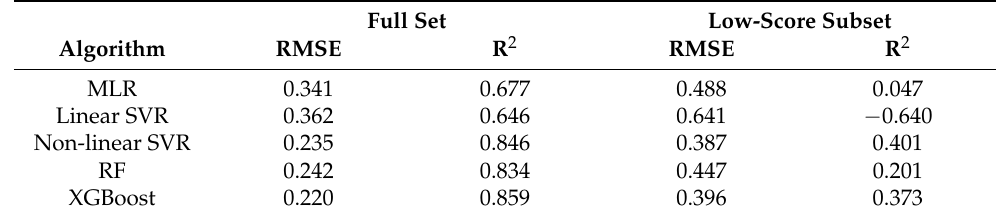
Table 3. RMSE and R 2 values for the MLR, Linear SVR, Non-linear SVR, RF, and XGBoost regression models for the full set and low-score subset.